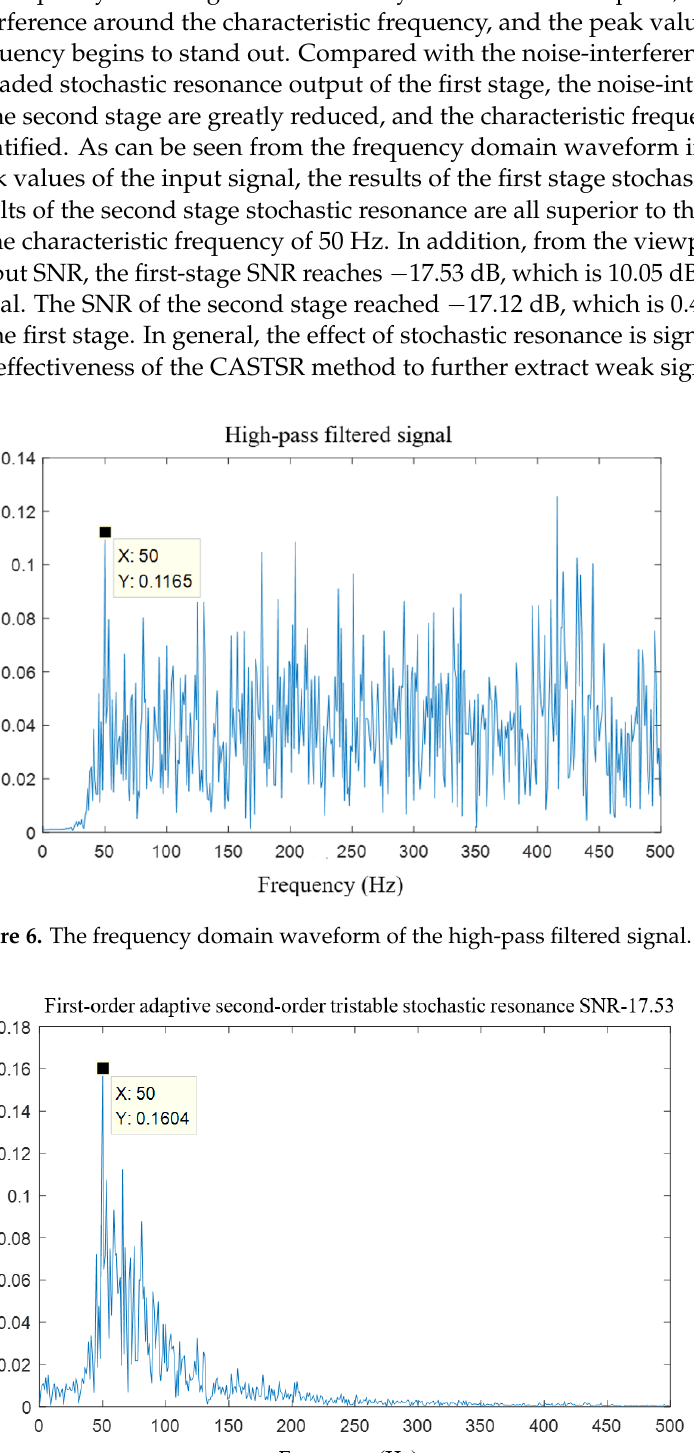
Figure 8. The output spectrum of the second cascade system. As can be seen from Figure 7, after the input signal goes through the first-order sto- chastic resonance, noise energy is transferred from the high frequency to the low fre- quency. As a result, the high-frequency noise is weakened, while the fault feature of the